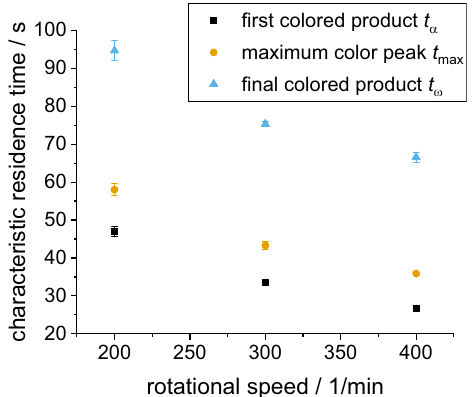
Figure 5: In fl uence of rotational speed on characteristic residence times of the extrudate for b - PET.